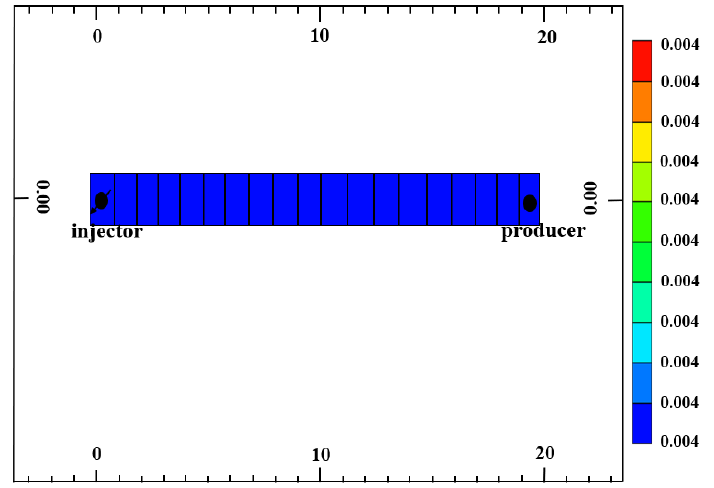
Figure 5. Numerical simulation diagram of slim-tube.